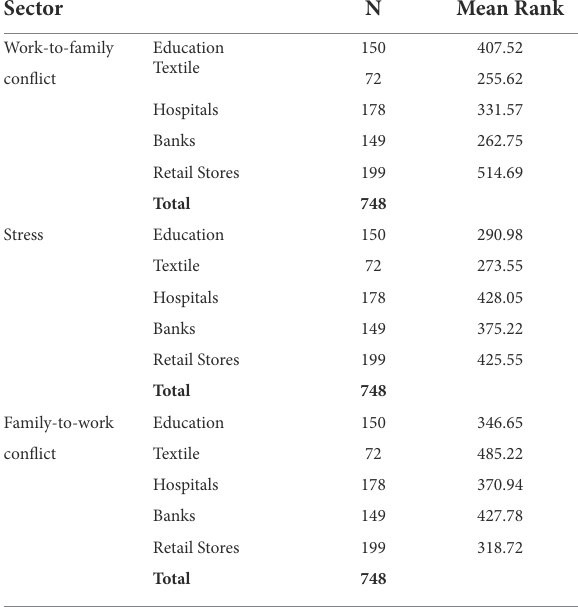
TABLE 9 Mean rank of